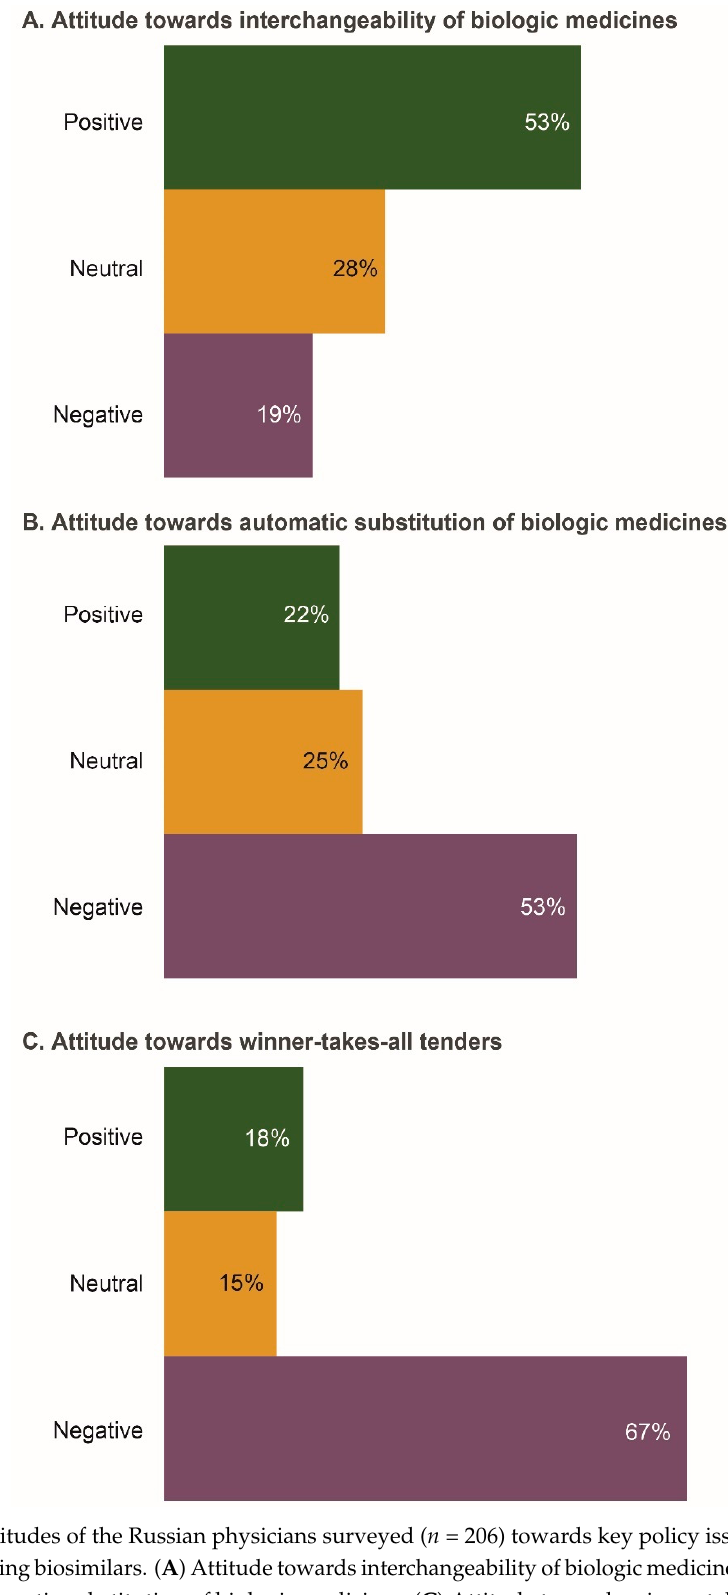
Figure 2. Attitudes of the Russian physicians surveyed ( n = 206) towards key policy issues associated with prescribing biosimilars. ( A ) Attitude towards interchangeability of biologic medicines; ( B ) Attitude towards automatic substitution of biologic medicines; ( C ) Attitude towards winner-takes-all tenders. Data were extracted from questions 7a, 7b, and 7d of the questionnaire (see Survey Questionnaire 1).